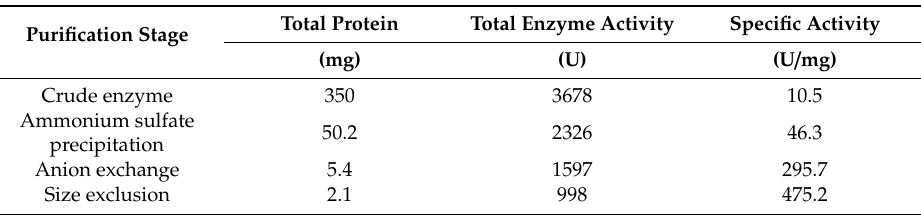
Table 1. Protease activity in purification process of EH2.